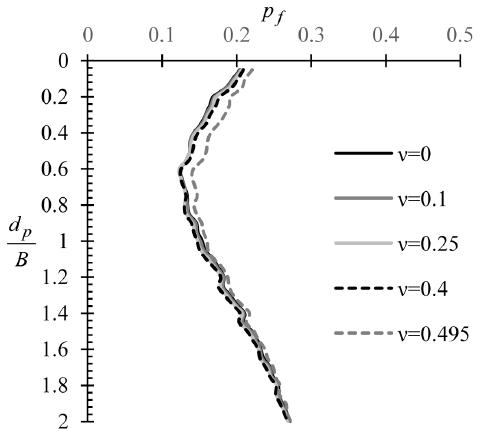
ff erent v values, x / B = 0 and θ / B =